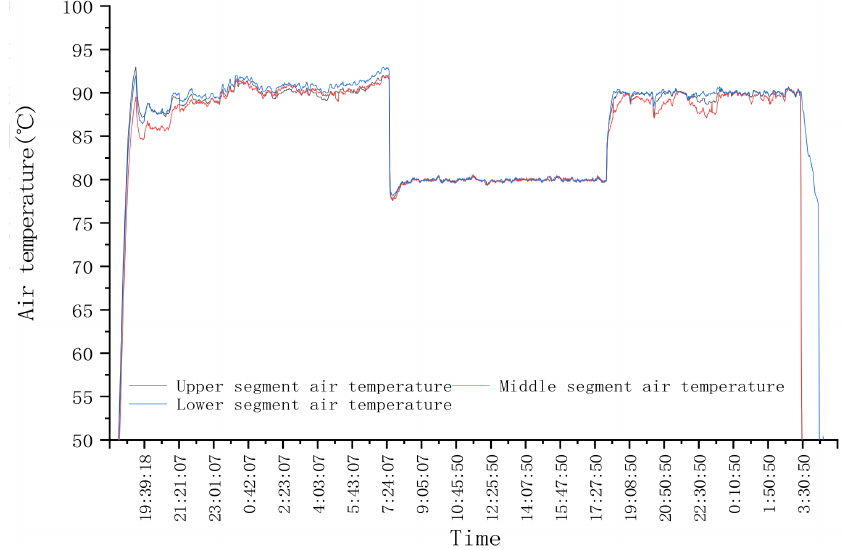
Figure 8. Variation of hot air temperature with time in the drying